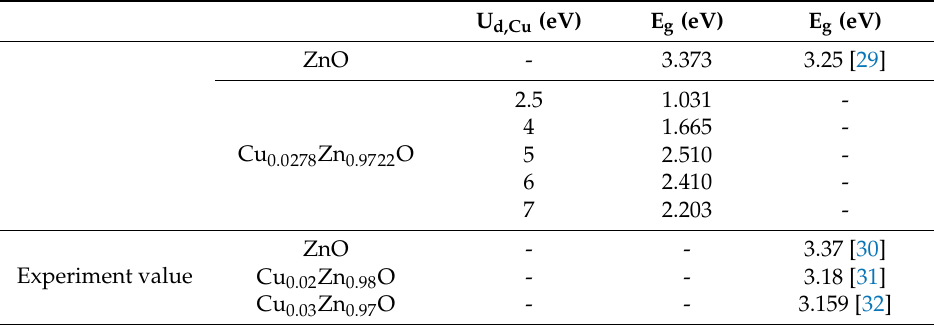
Table 2. Band gap calculated by different U